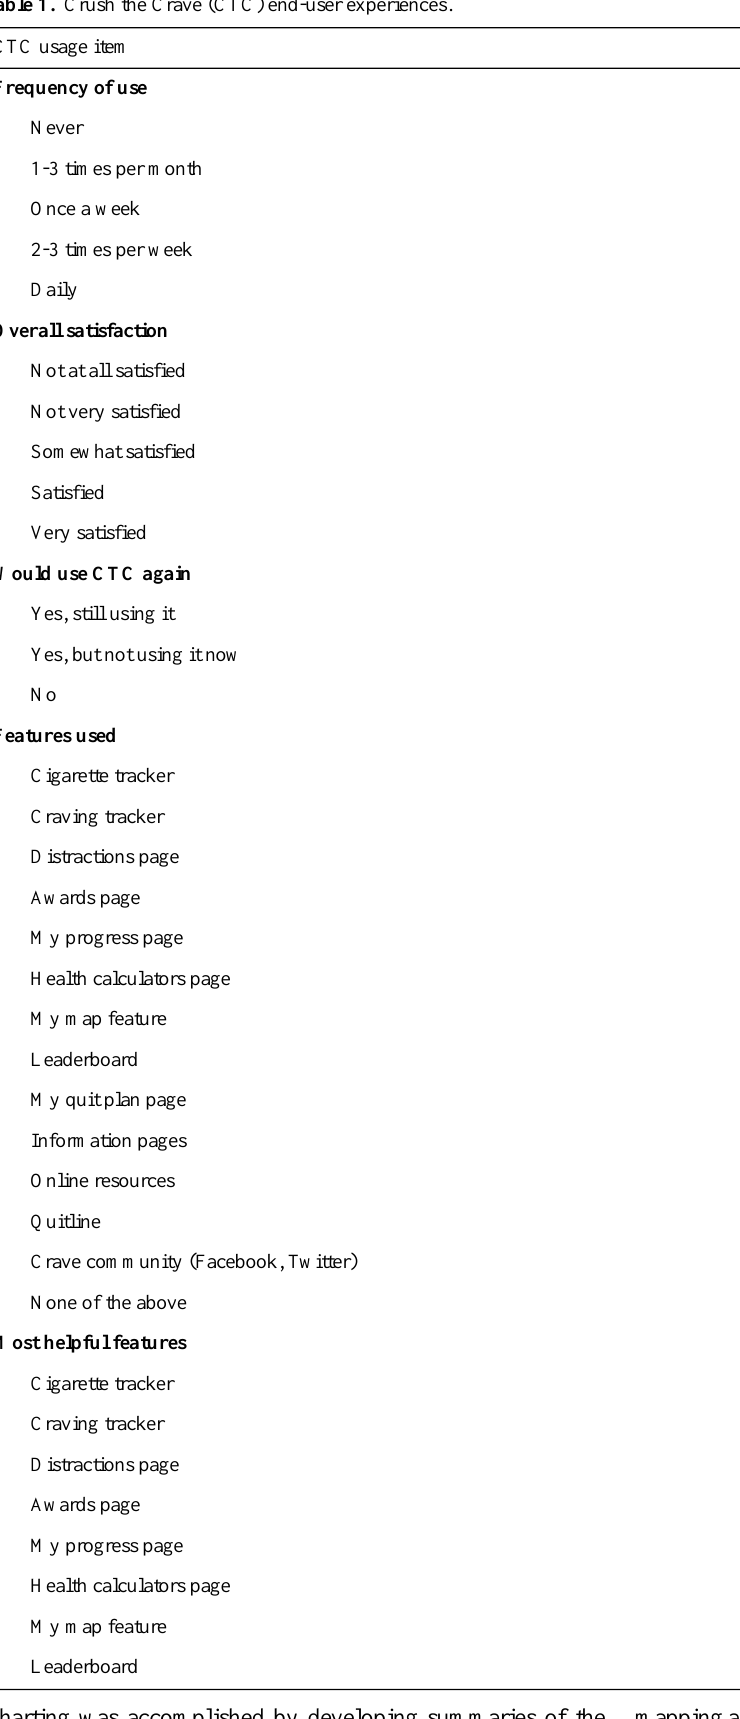
Table 1. Crush the Crave (CTC) end-user